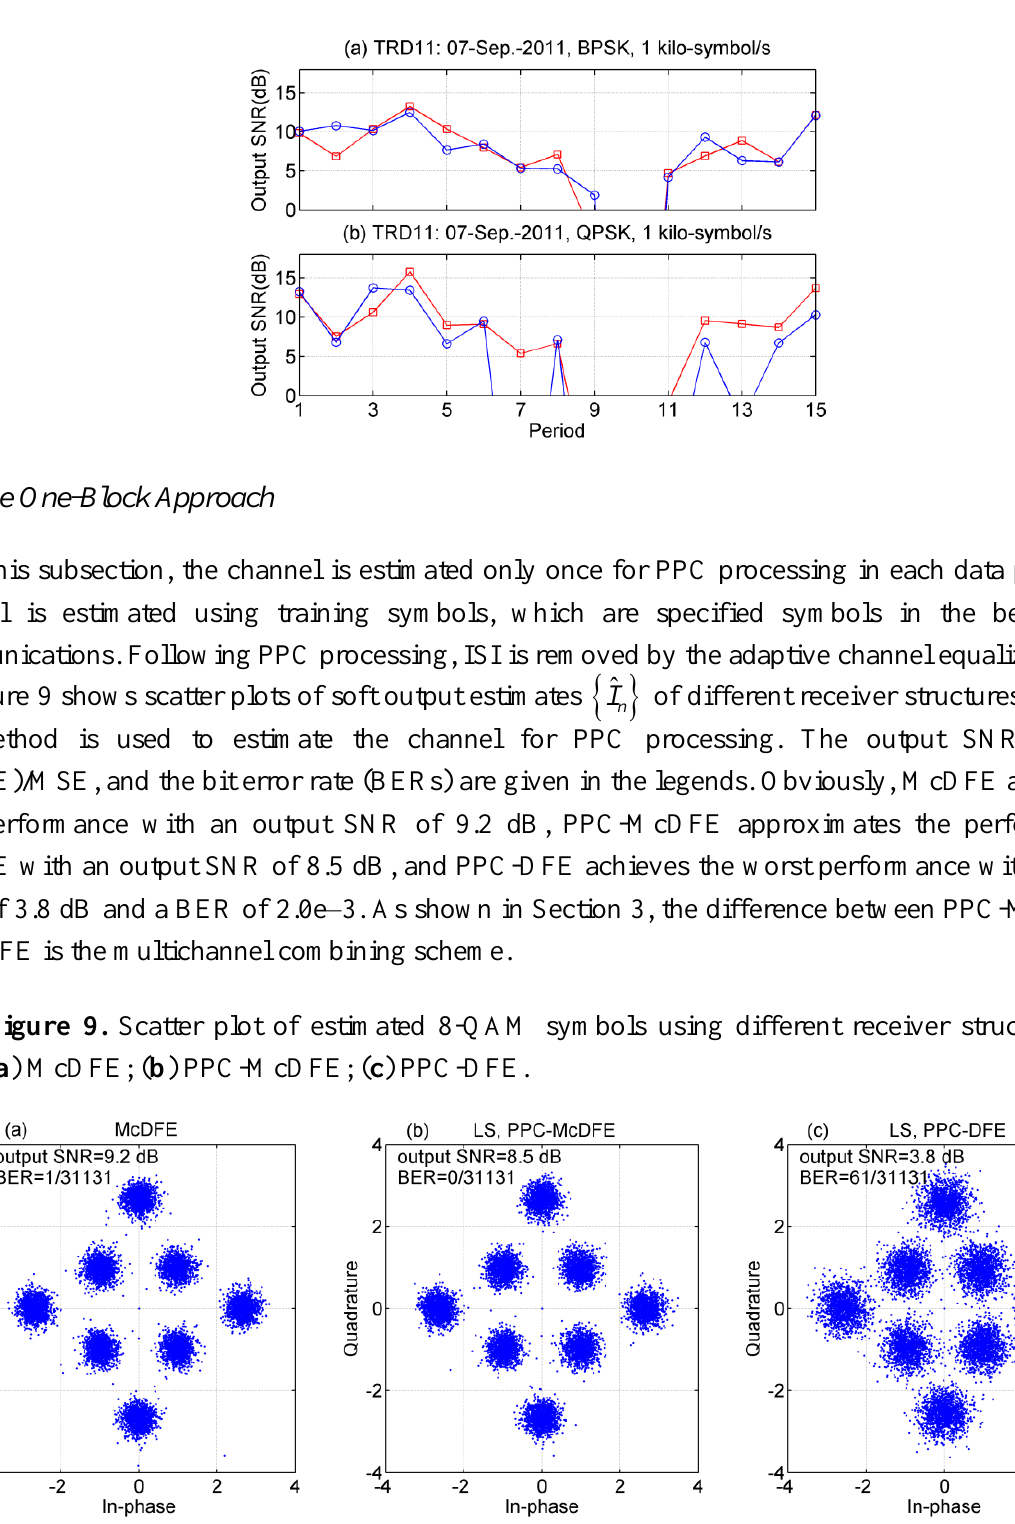
Figure 8. Performance of PPC-DFE using different shaping pulses. ( a ) BPSK; ( b ) QPSK. LFM is used (□), and RRC is used (○).